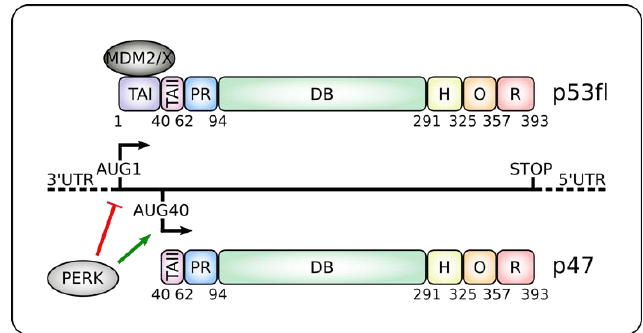
Figure 1. Alternative translation initiation products from the p53 mRNA. Alternative translation initiation from codons AUG1 or AUG40 gives rise to canonical p53 full-length (p53fl) or the shorter p47 isoforms, respectively. Endoplasmic reticulum (ER) stress and induction of the Unfolded Protein Response (UPR) leads to protein kinase RNA-like ER kinase (PERK) kinase activation that suppresses cap-dependent synthesis of p53fl and favors IRES-dependent translation initiation of p47 [58–62]. p47 lacks the MDM2 and MDMX binding sites and the transactivation domain I (TAI), which controls transcription of some typical p53-target genes such as p21 and MDM2 (see text and Table 1) [63]. p47 retains the oligomerization (O) domain and can form hetero- or homo-oligomers. It also keeps the Proline-rich (PR), DNA-binding (DB), hinge (H) and C-terminal regulatory (R) domains. Numbers below the proteins denote the location of the different domains. 3’ and 5’ UTRs: Untranslated regions.